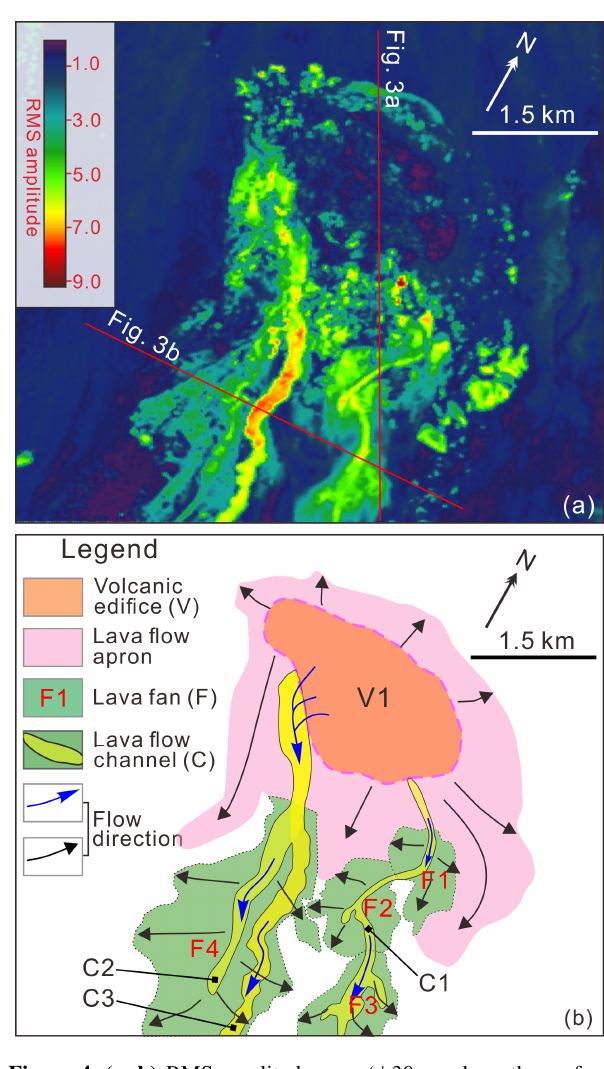
Figure 4. (a, b) RMS amplitude map ( ± 30ms along the surface BM) and its interpretations. Volcanic apron, lava flow channels, and fans are labelled. See map location in Fig. 1b. Red lines in panel (a) show locations of seismic profiles in Fig.